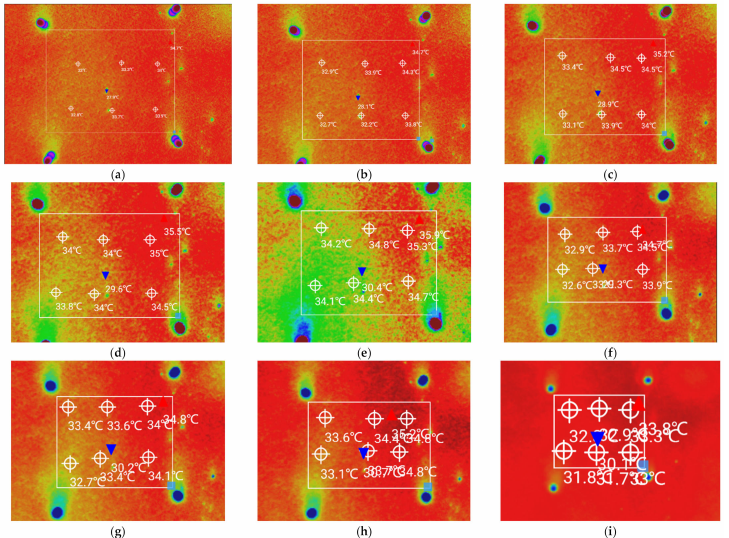
Figure 4. Infrared images at different measurement heights: ( a ) h = 3 m, ( b ) h = 4 m, ( c ) h = 5 m,